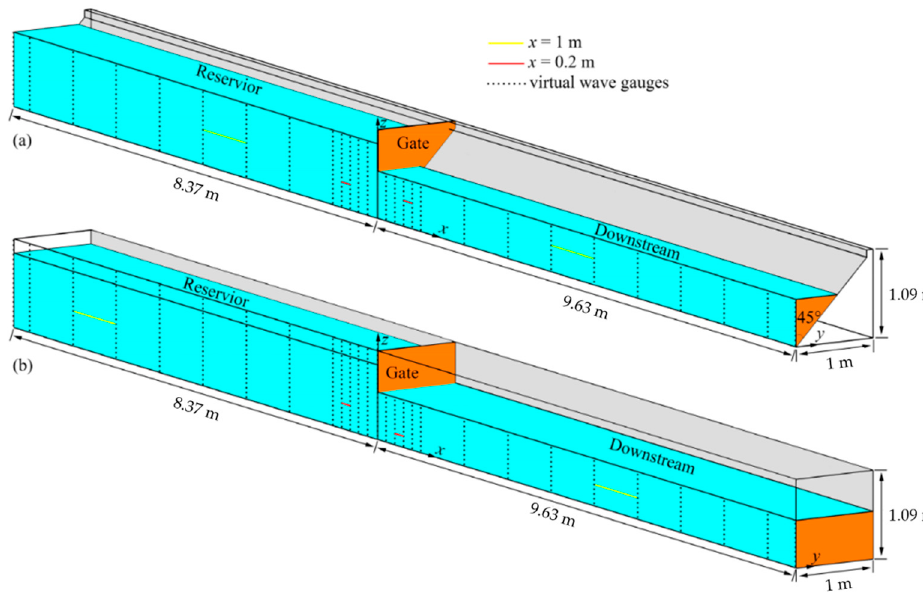
Figure 2. Schematic diagram of the channels in the present study: ( a ) A triangular channel; ( b ) a rectangular channel.